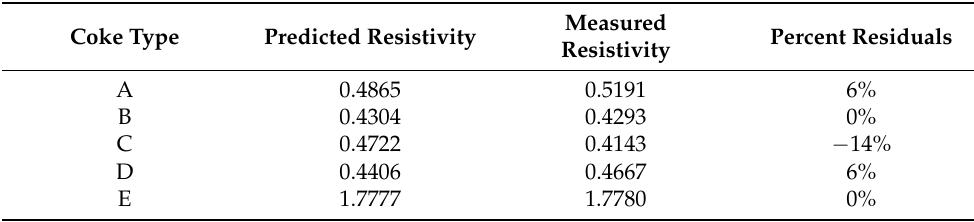
Table 9. Correlation matrix of coke resistivity and coke porosity while controlling for both precent isotropic carbon content and ash